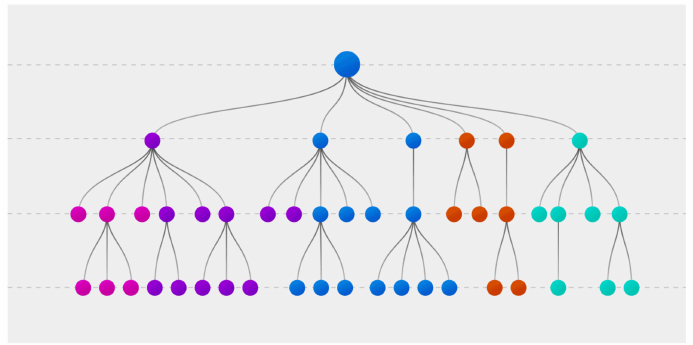
Figure 6. An example of the structure of a decision tree algorithm